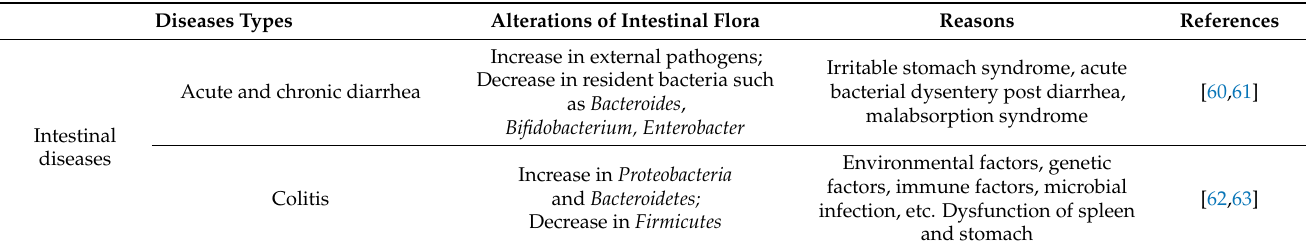
Table 2. Changes of intestinal flora in